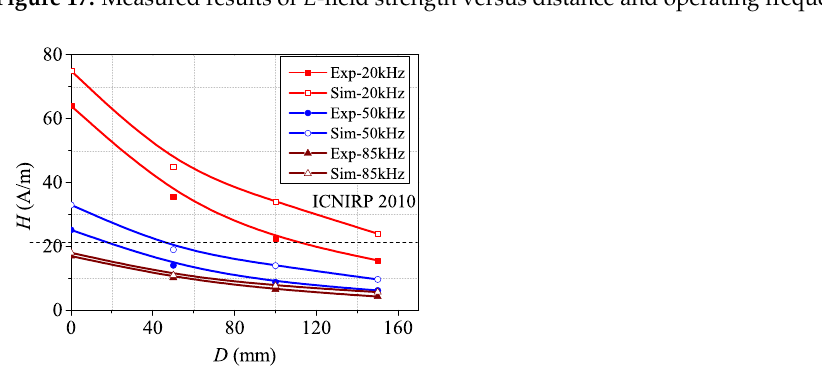
Figure 17. Measured results of E -field strength versus distance and operating frequency.